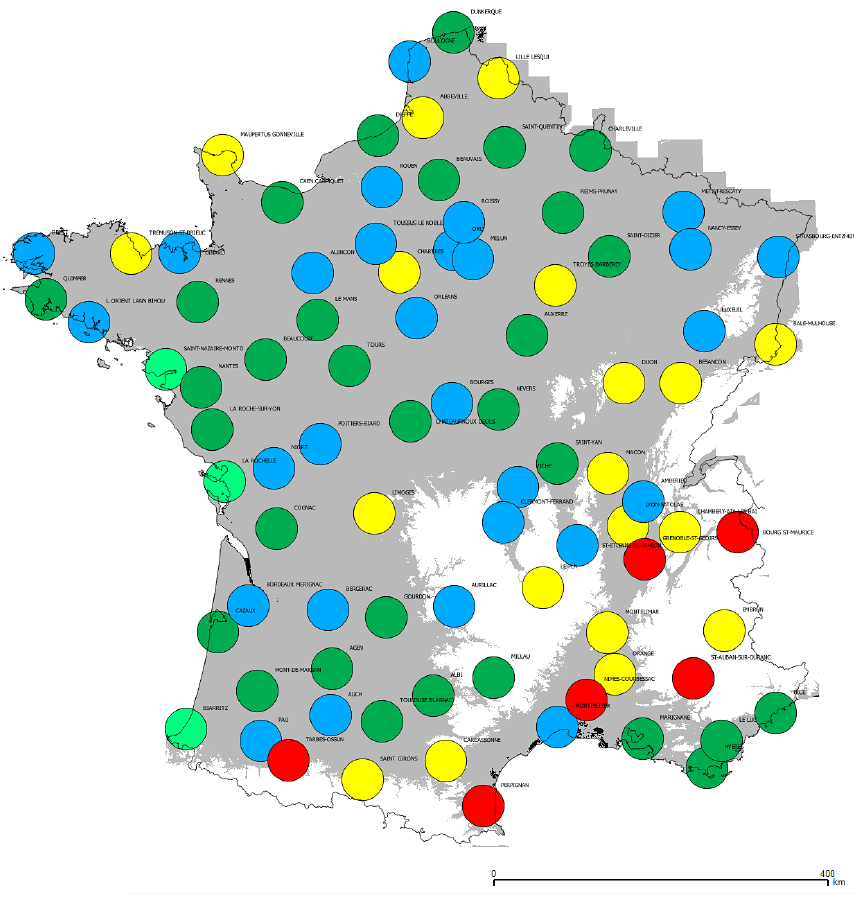
Figure 4. ISO ICs for the 87 French weather stations of the study (pale green: R1; dark green: R2; blue: R3; yellow: R4; red: R5; white area: area above 500m).